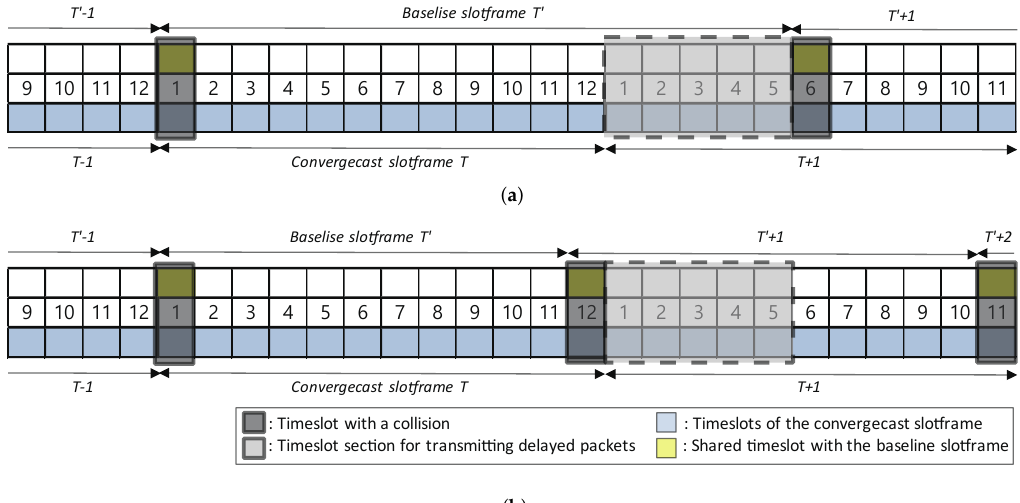
Figure 7. Timeslot section where collisions should be avoided. ( a ) A case where the baseline slotframe size (17) is greater than the convergecast slotframe size (12); ( b ) a case where the baseline slotframe size (11) is smaller than the convergecast slotframe size